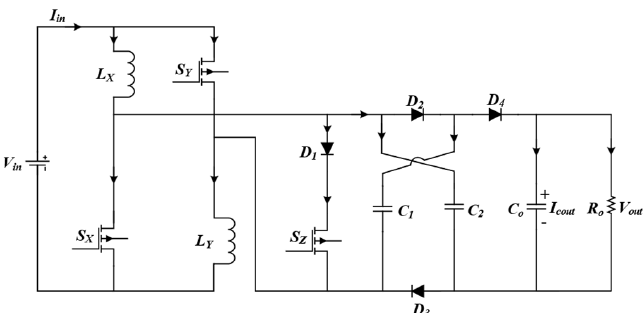
Figure 1. Proposed non-isolated high-gain non-inverting interleaved converter.